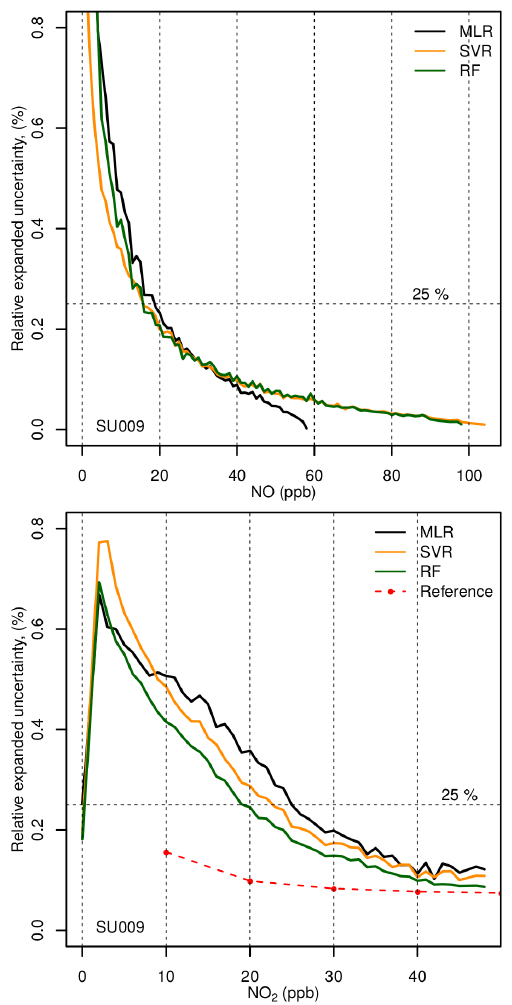
Figure 9. Comparison of expanded relative uncertainty and refer- ence NO and NO 2 concentration for the SU009, as deployed at the urban background site Zurich-Kaserne, using 1h average